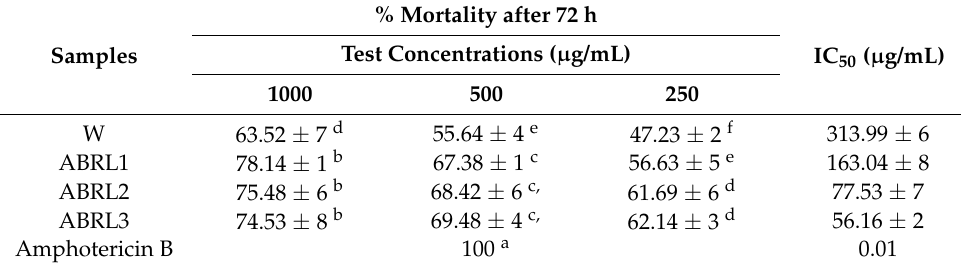
Table 6. Antileishmanial activity of Ajuga bracteosa .